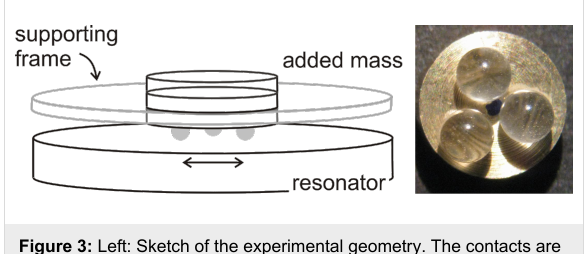
Figure 3: Left: Sketch of the experimental geometry. The contacts are formed between a tripod (center top) and the resonator plate. The three spheres (in grey) carry an equal normal load and experience equal amplitudes of oscillation. The normal force is changed by adding weight on the top. A fixed frame around the tripod ensures that the tripod does not shift when weight is added or removed at the top. Right: Image of a